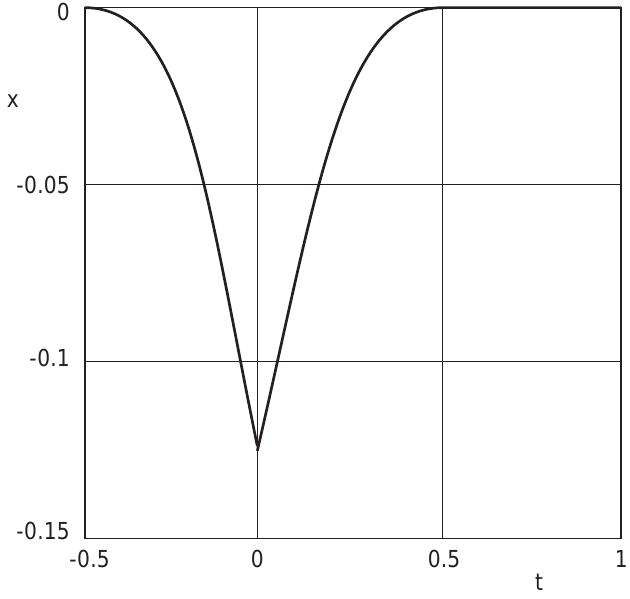
Fig. 6. Time history of the relative displacement of the object corresponding to the constant force pre-acting